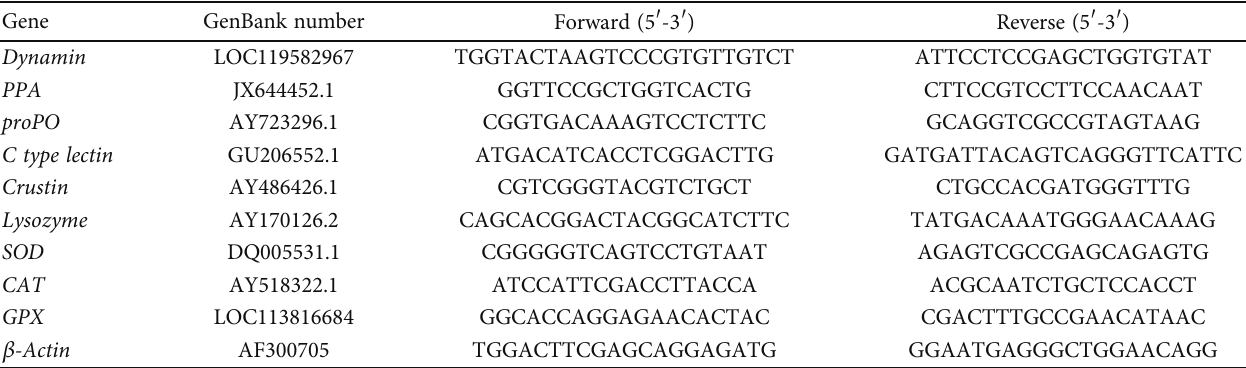
Table 2: Primer information.